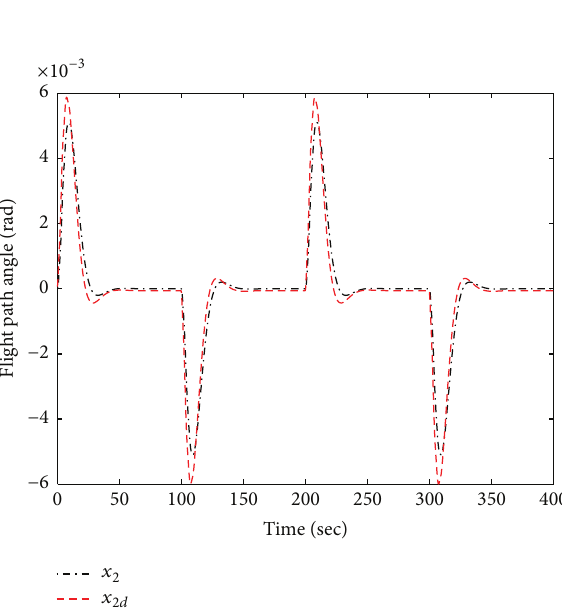
Figure 4: Throttle setting.